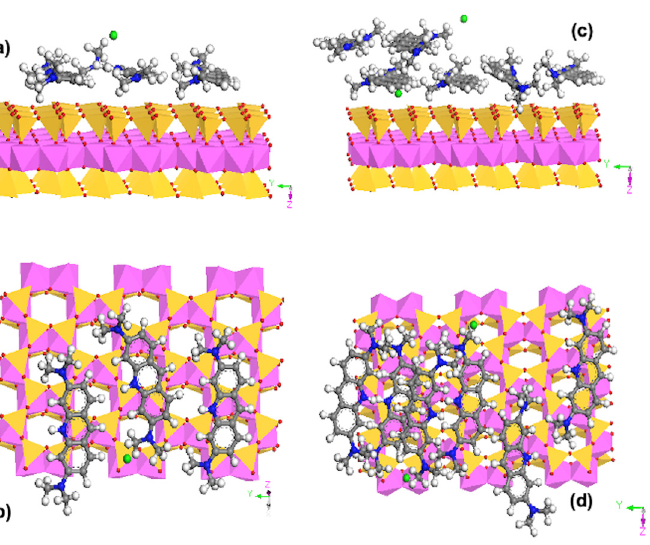
Figure 11. Molecular dynamics simulation showing AO configuration on IL at low ( a , b ) and high ( c , d ) sorption levels. Zn: green.